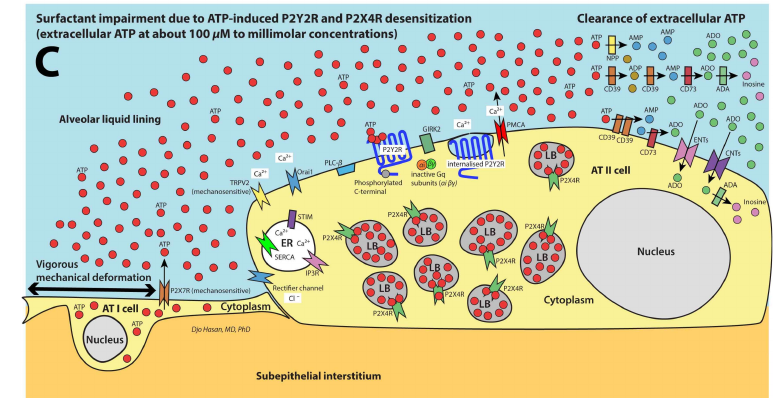
Figure 1. Schematic presentation of the regulation of surfactant exocytosis. For greater clarity, the high cytosolic adenosine triphosphate (ATP) content is omitted in the figure. ( A ) Resting state of the alveolar epithelial type I (AT I) and AT II cells. ( B ) ATP-induced fusion- activated calcium-ion entry resulting in surfactant exocytosis. ( C ) Excessive extracellular ATP concentrations causing the impairment of surfactant exocytosis. See text for explanation. AT I: Alveolar epithelial type I cell; AT II: Alveolar epithelial type II cell; ER: Endoplasmic reticulum; LB: Lamellar body; P2Y2R and P2X4R: ATP receptors; Gq/11: G protein-coupled receptor molecules comprising α i and βγ subunits; PLC- β : Phospholipase C beta; PIP2: Phosphatidylinositol 4,5-bisphosphate; IP3: Inositol triphosphate; IP3R: Inositol triphosphate receptor, a membrane bound glycoprotein complex functioning as a Ca 2+ channel sensitive to activation by IP3; STIM1: Stromal interaction molecule 1, a calcium sensor; Orai1: Calcium release-activated calcium channel protein 1, a calcium selective ion channel; TRPV2: Transient receptor potential cation channel subfamily V member 2, a non-selective cation channel; Kir3: K + selective inwardly rectifying channel 3 or GIRK2: G protein-coupled inwardly-rectifying K + channel 2; DAG: diacylglycerol; PKC: protein kinase C; CD39: Nucleoside triphosphate diphosphohydrolase 1 (NTPD1); NPP: nucleotide pyrophosphatase/phosphodiesterase; CD73: 5 (cid:48) -nucleotidase (5 (cid:48) -NT); ADA: adenosine deaminase; ENTs: Equilibrative nucleoside transporters 1 and 2; CNTs: Concentrative nucleoside transporters 1 and 2; FACE: fusion-activated Ca 2+ entry; SERCA: sarcoplasmic/endoplasmic reticulum Ca 2+ ATPase channel; PMCA: Plasma membrane Ca 2+ ATPase channel. Figures extensively adapted from Hasan, et al. (2017) [10] (open access) with